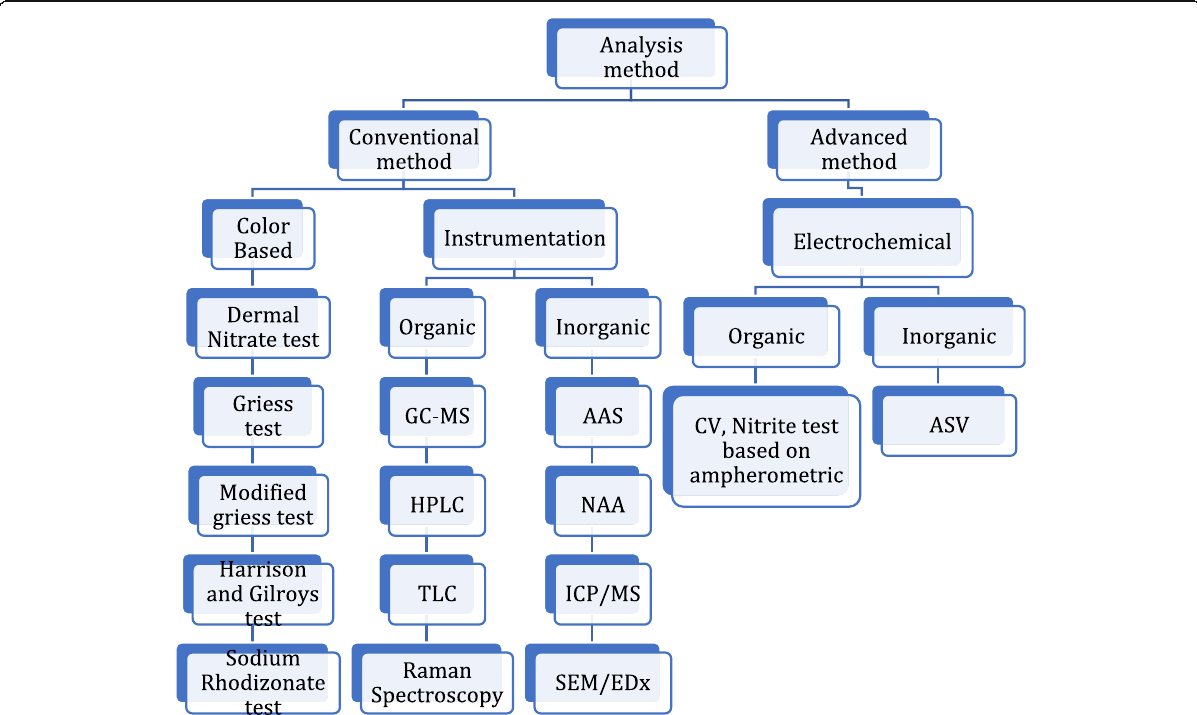
Fig. 3 Flowchart showing schematic diagrammatic representation of various developed method to detect GSR. ASV, abrasive stripping voltammetry; SEM/Edx, scanning electron microscopy/energy dispersive X-ray analysis; CV, cyclic voltammetry; ICP/MS, inductively coupled plasma mass spectrometry; TLC, thin-layer chromatography; NAA, neutron activation analysis; AAS, atomic absorbance spectrometry; GC-MS, gas chromatography-mass spectroscopy; HPLC, high-pressure liquid top and the cloth sample bearing the sample of gunshot placed over it and covered with 20% CH COOH and 3 then pressed with a hot electric iron. A dark red color spot indicates the presence of GSR (Walker, 1940).